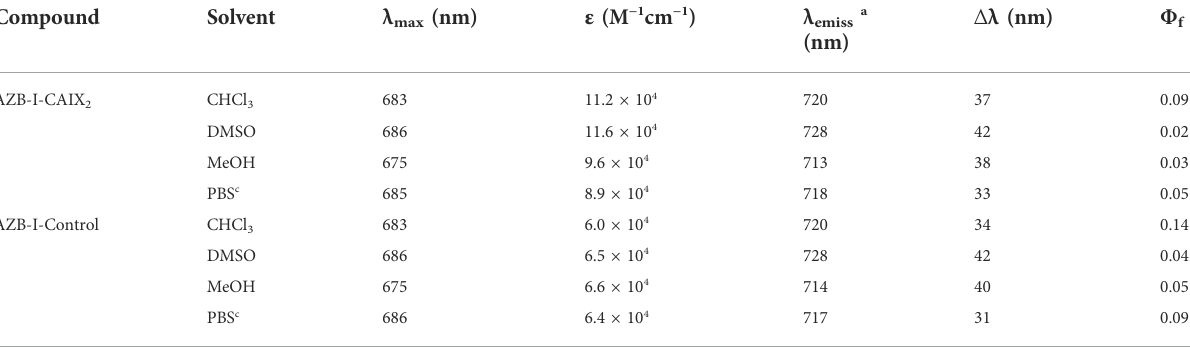
TABLE 1 Photophysical properties of AZB-I-CAIX 2 and AZB-I-control (1 μ M).